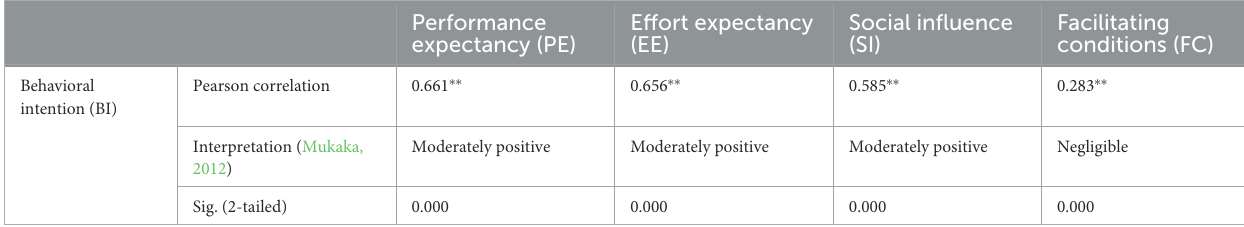
TABLE 2 Correlation between each of the factors and the respondents’ behavioral intentions to use technology in the post-COVID-19 era.